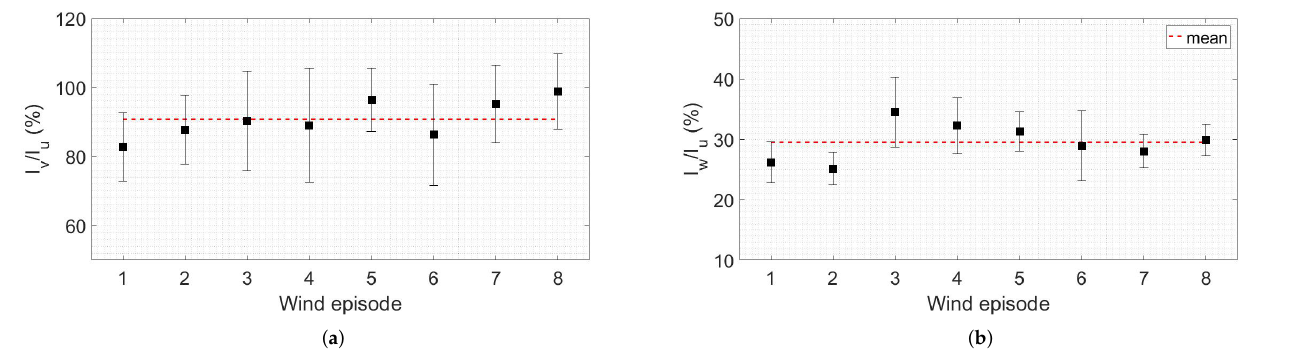
Figure 11. Grand mean values of ( a ) lateral and along-wind turbulence intensity ratio and ( b ) vertical and along-wind turbulence intensity ratio, expressed as a percentage and obtained for each wind episode from the mean values of intensity ratios at 11 measurement heights, from 80 to 180m. Red dotted line denotes the mean of all wind episodes. Table 3. Grand mean values of lateral/vertical and along-wind turbulence intensity ratio, obtained for each wind episode from the mean values of intensity ratios at 11 measurement heights, from 80 to 180m. The ratios are expressed as a percentage and are presented by their median, mean, standard deviation, minimum and maximum